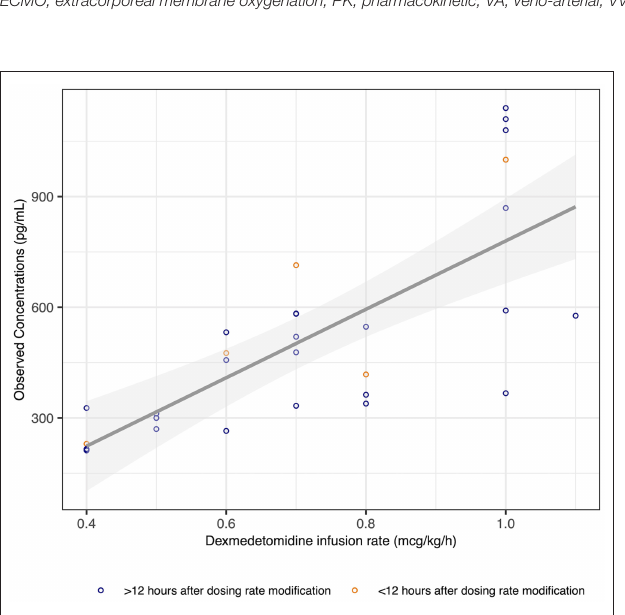
FIGURE 1 | Dexmedetomidine concentrations vs. infusion